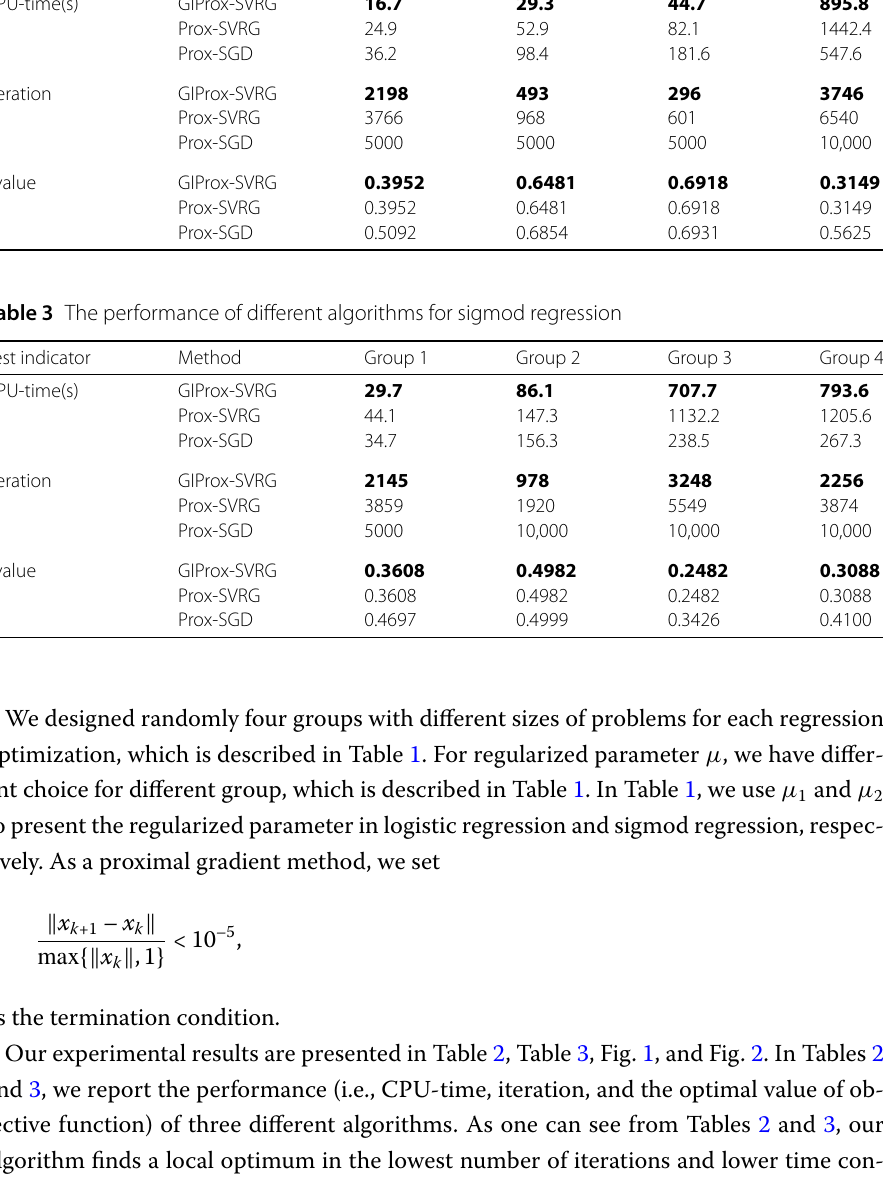
Table 2 The performance of different algorithms for logistic regression Test indicator